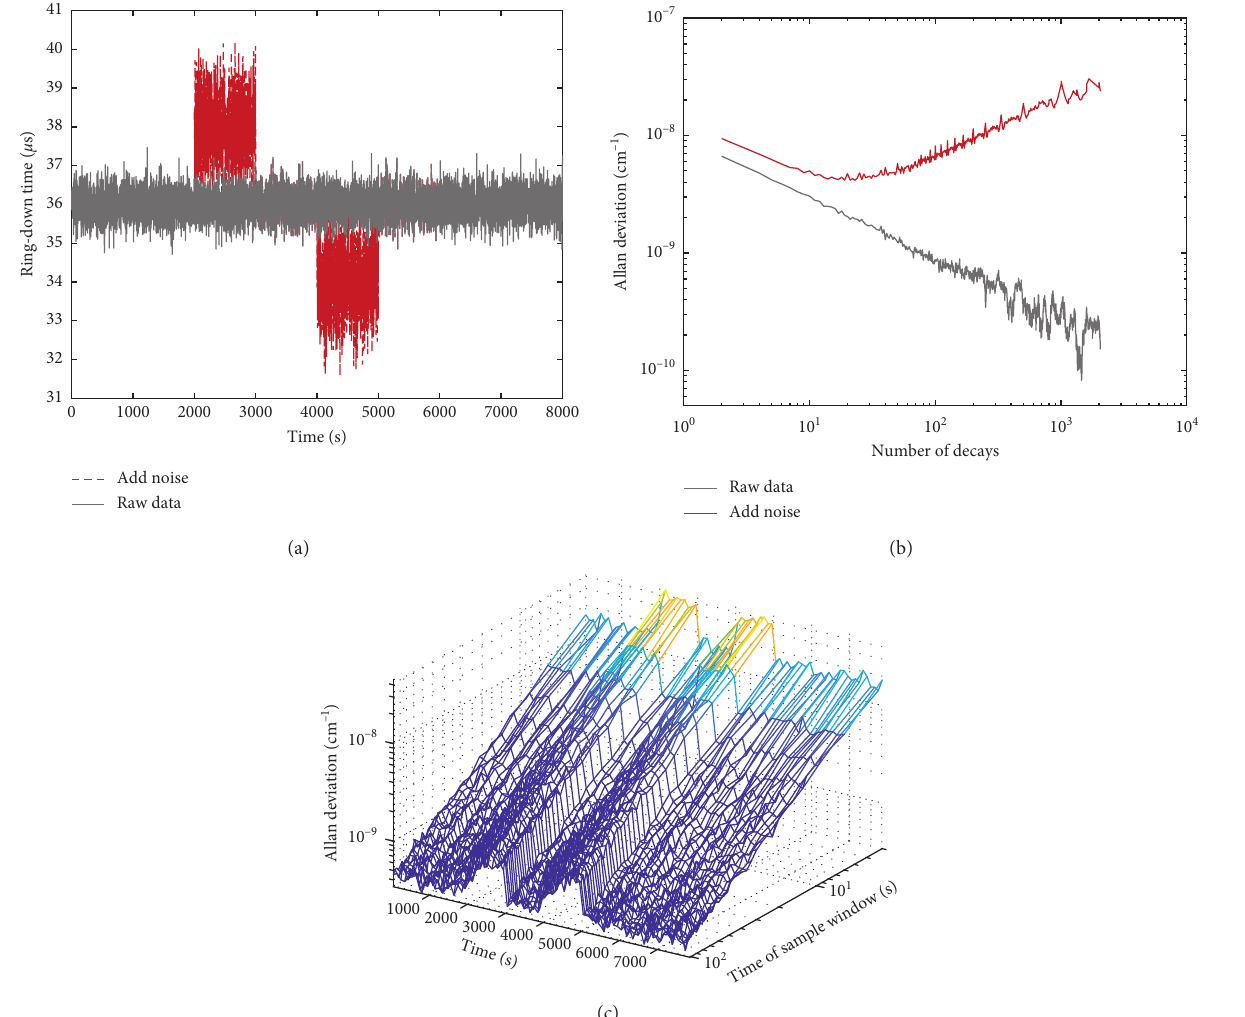
Figure 2: Allan variance and DAVAR analysis of sudden-changed signals. (a) Add sudden noise to ring-down time series. (b) Using Allan variance to analyze the effect of noise on detection accuracy. (c) DAVAR analysis detection accuracy changes over